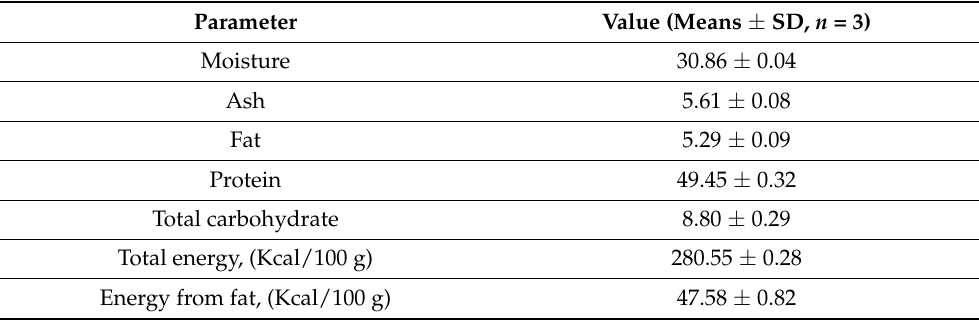
Table 1. Proximate compositions of odonate larvae, Pantala sp., g/100 g dry